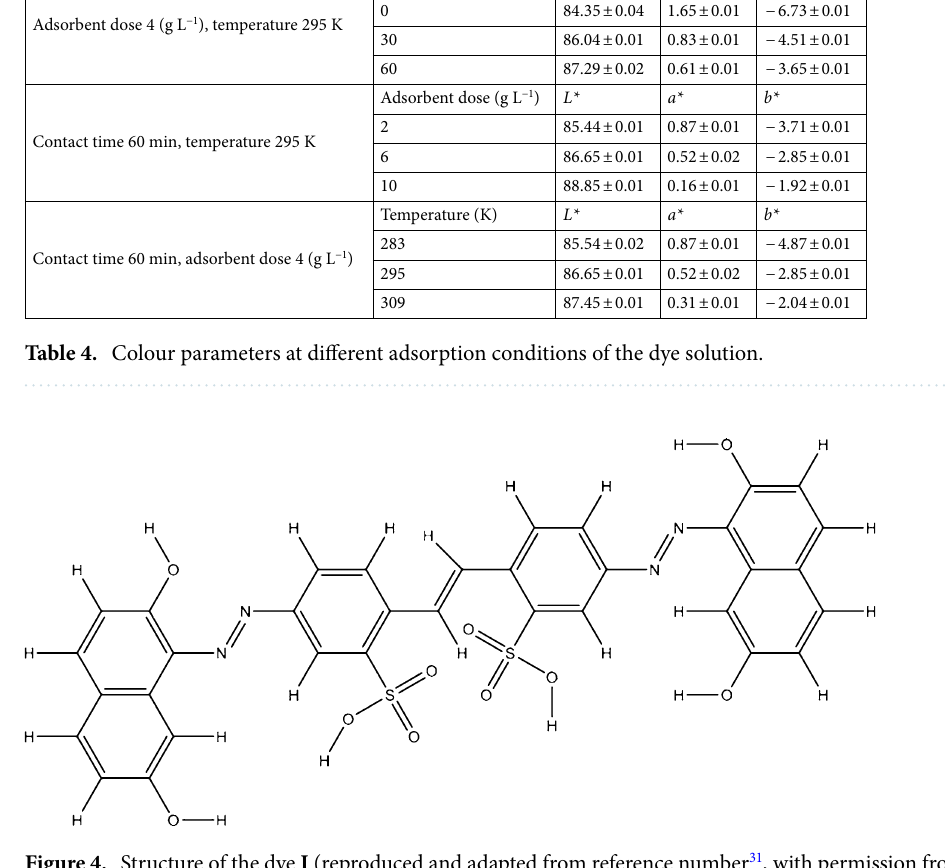
Figure 4. Structure of the dye I (reproduced and adapted from reference number 31 , with permission from